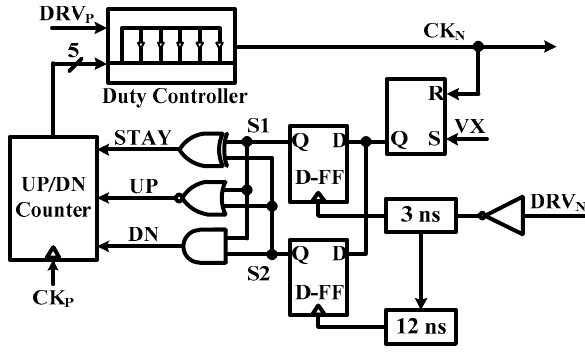
Figure 16. Schematic of proposed SC-NCD. Sensors 2019 , 19 , x FOR PEER REVIEW